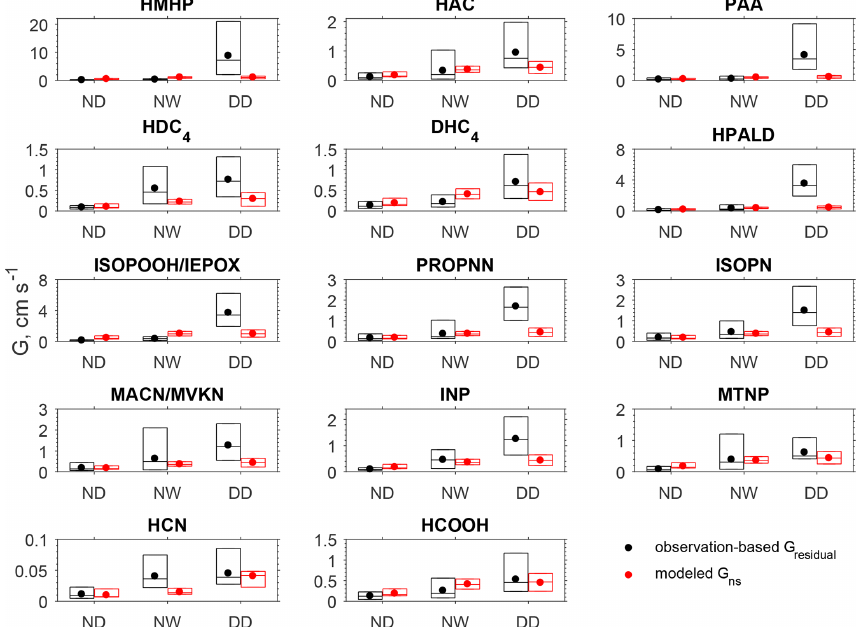
Figure 3. Box plot of the observation-based residual conductance ( G residual ) and the modeled non-stomatal conductance ( G ns ) during the nighttime dry period (ND, n = 88), nighttime wet period (NW, n = 40), and daytime dry period (DD, n = 85). In each box, the central mark is the median, and the edges of the box are the 25th and 75th percentiles. The filled dots represent the arithmetical mean of data between the 25th and 75th percentiles. Daytime is 09:00–17:00 (local time) and nighttime is 20:00–06:00 (local time). The wet surface conditions were determined in the model driven by the observations of relative humidity, precipitation rate, friction velocity, and temperature. Table 2. Statistical results of the observed and modeled dry deposition velocity ( V d ) for oVOCs and HCN (cms − 1 ) ∗ . Compound All Daytime Nighttime N Obs Mod Mod- R s , min R N